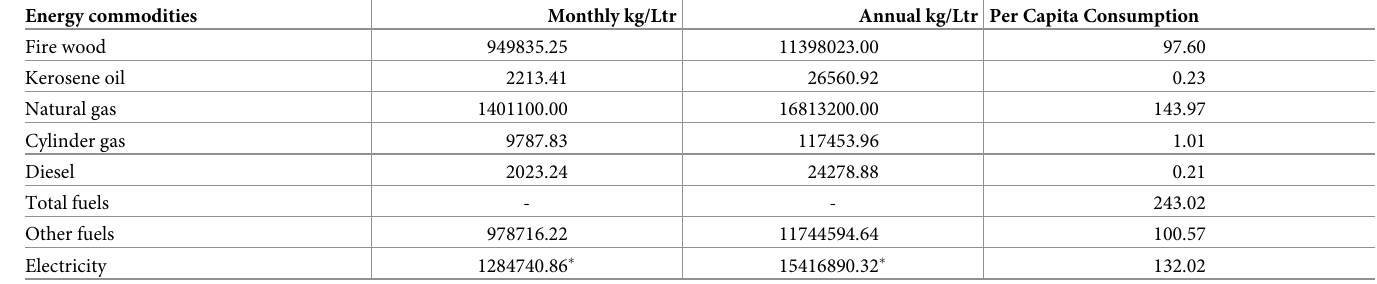
Table 11. Total per capita household consumption in